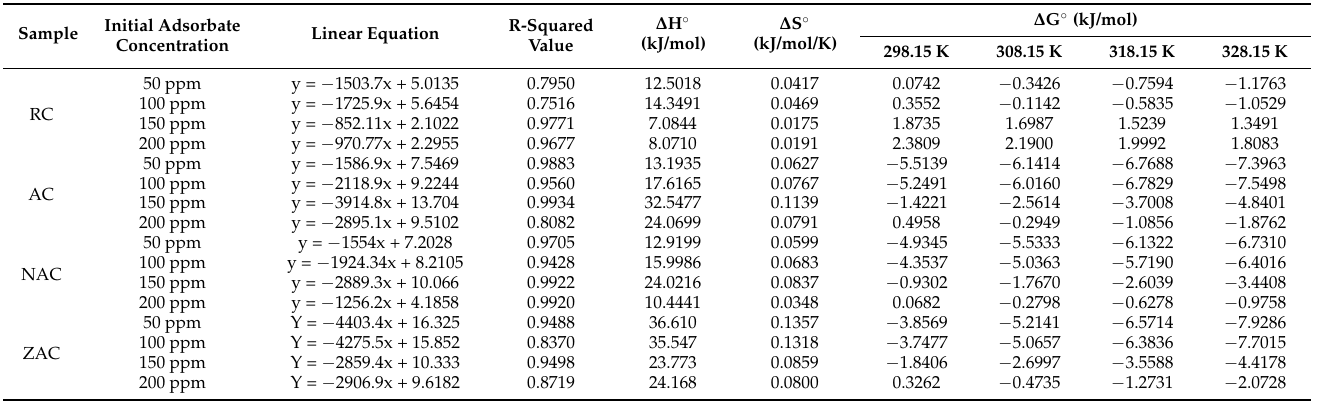
Table 8. Thermodynamic parameters for the adsorption of ofloxacin onto all types of cassava stem